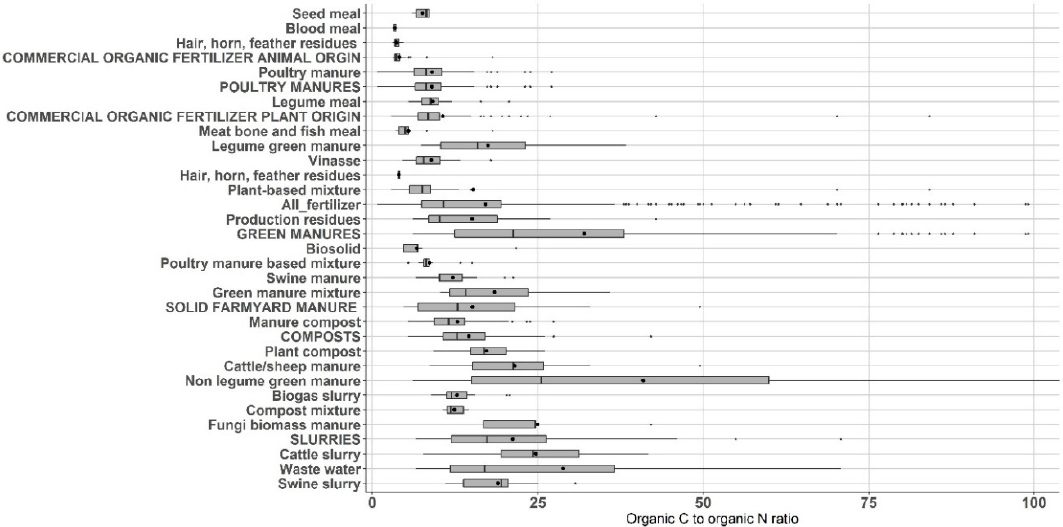
Figure 3. Boxplot of organic C to organic N ratio in the fertilizer main groups (capital letters) and subgroups. The circles are means and the stripes are the medians of the observations.